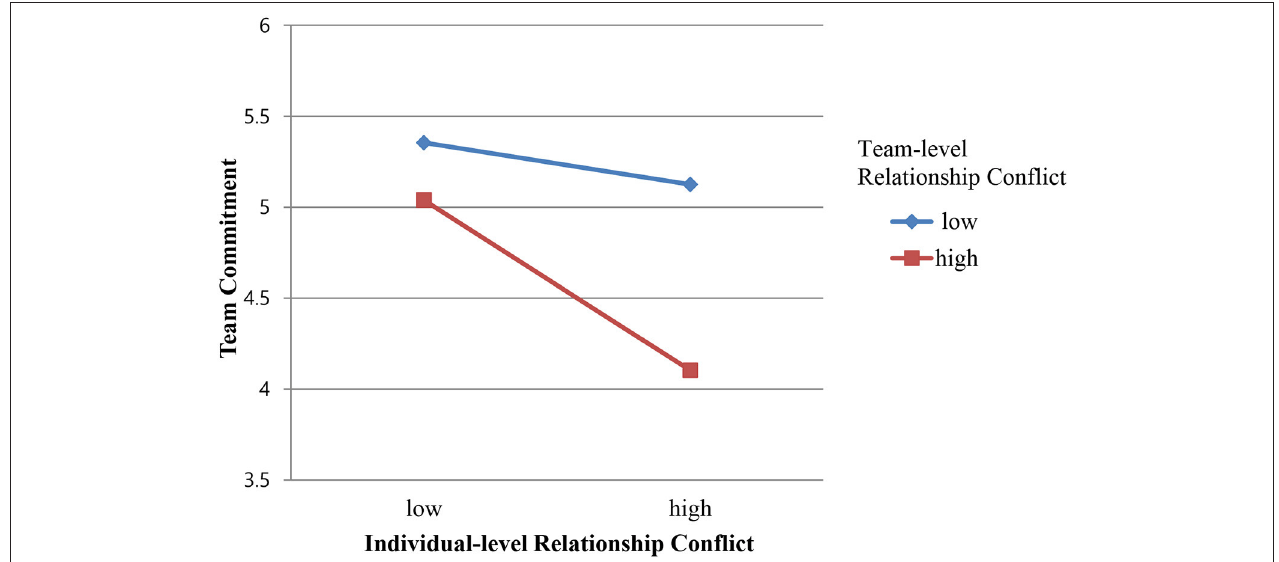
FIGURE 2 | Plot of cross-level moderating effects of team-level relationship conflict on the relationship between individual-level relationship conflict and team